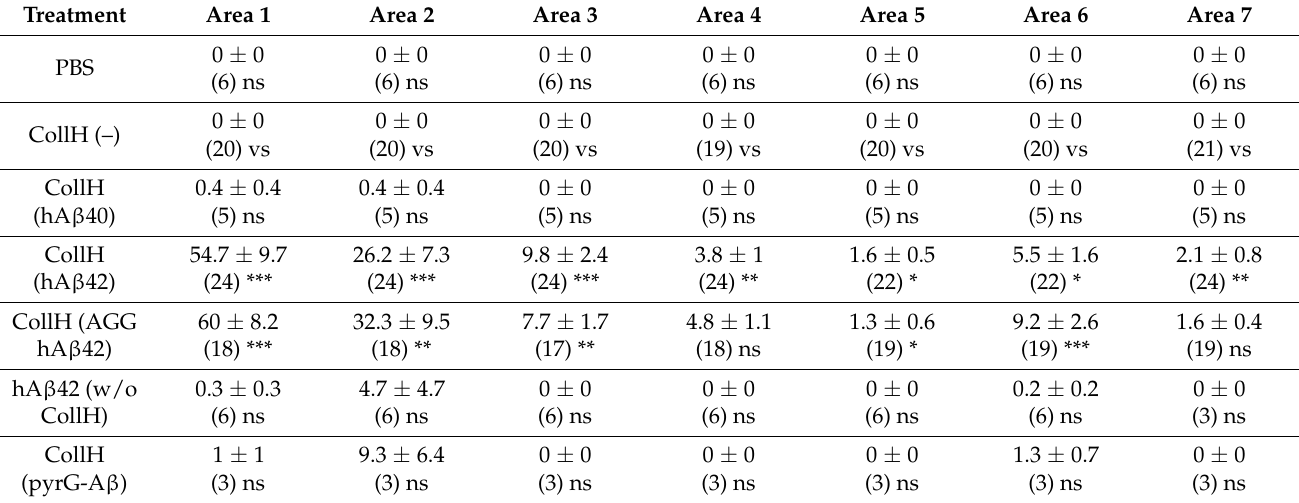
Figure 4. Western blot of beta-amyloid (A β ). Beta-amyloid peptides (500 ng) were loaded onto gels and stained with a beta-amyloid antibody. Note that the antibody detected a 4 kDa monomer and an 8 kDa dimer peptide of human A β 42 and a 4 kDa peptide of human A β 40 but not mouse A β 42 . Human A β 42 was allowed to aggregate and showed a smear of higher 40–80 kDa aggregated species. As a negative control, a reversed (REV) peptide was loaded. When A β 42 was incubated for eight weeks (without slices), three major bands were visible: at 4, 12 and approximately 80 kDa. Slices incubated for eight weeks with a collagen-loaded A β 42 (CollH(A β 42 )) hydrogel showed two major bands at approximately 40 and 80 kDa, pointing to aggregation stages during long-term culturing, while no staining was visible in slices incubated with an empty collagen hydrogel (CollH(-)). Table 1. Quantification of spreading in organotypic